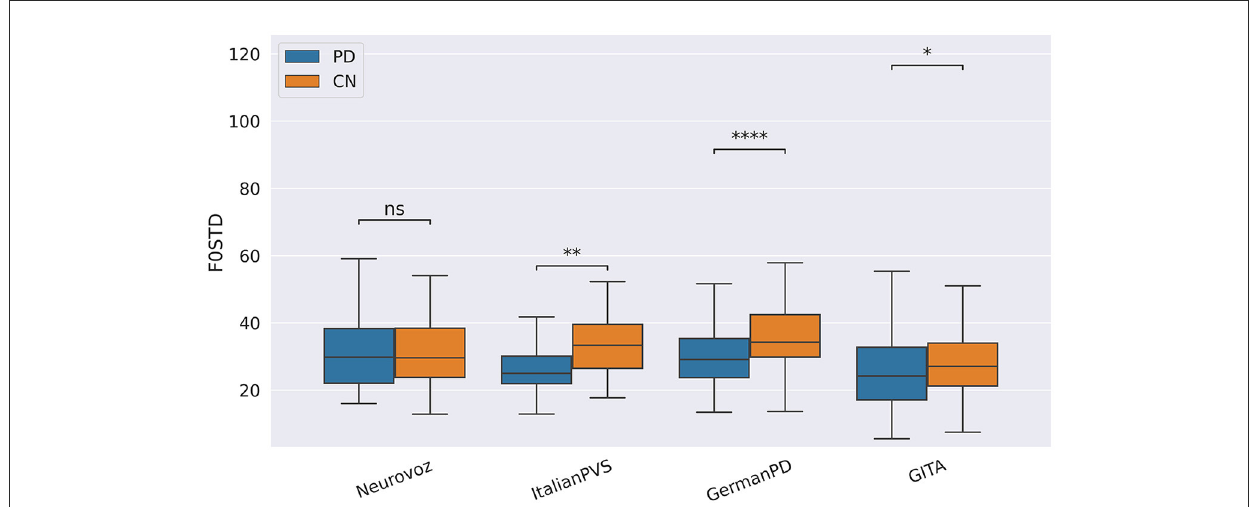
FIGURE1 Boxplots with statistical annotations representing the standard deviation of F0 (F0STD) on Neurovoz, ItalianPVS, GermanPD, and GITA from the TDU task. Horizontal lines represent the median, the top ends represent the upper quartile, and the bottom ends represent the lower quartile. Statistically significant differences between groups after Benjamini–Hochberg correction for F0STD are reported in Table 5 and highlighted below using asterisks. F0STD, F0 standard deviation; CN, controls; PD, Parkinson’s disease; TDU, text dependent utterance; ns, not